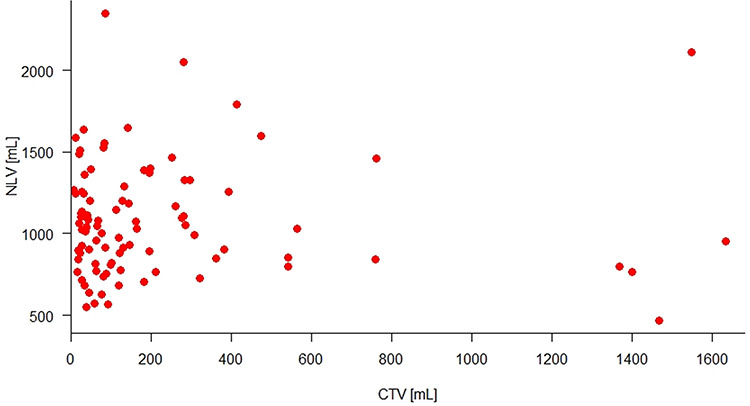
NLV has no correlation with CTV.